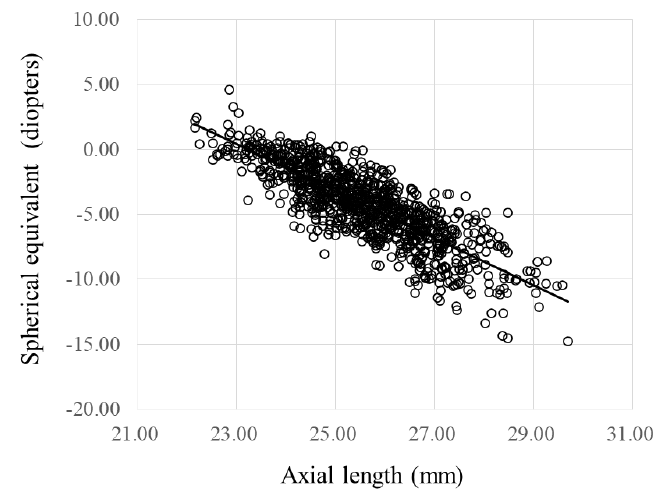
Figure 2. Spherical equivalent and axial length. y = 42.07 − 1.81x, r 2 = 0.687, p < 0.001. ○ , data of eyes in each student.